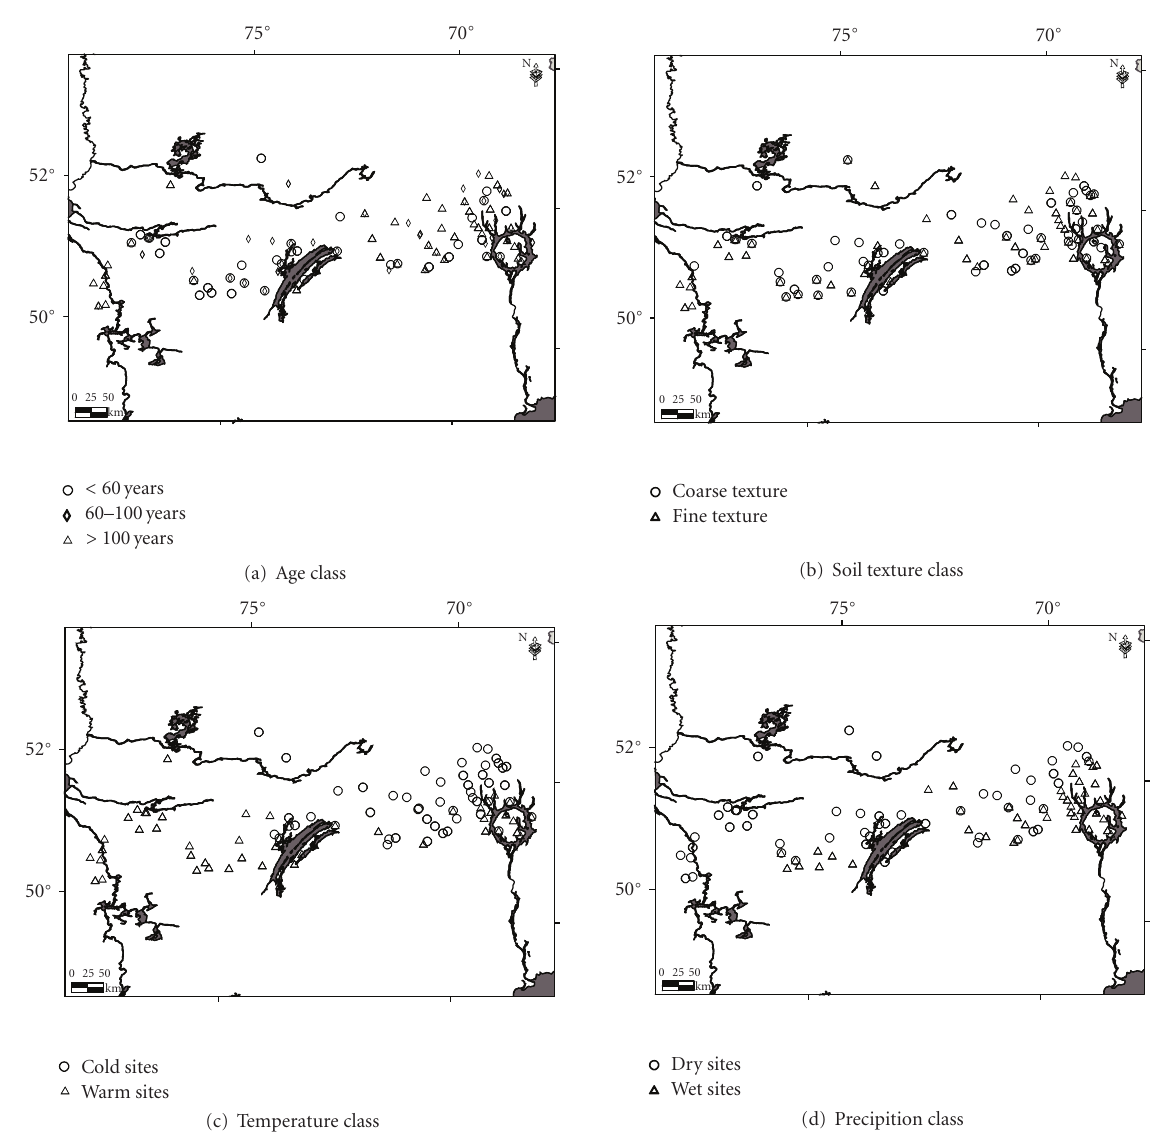
Figure 2: Distribution of stand age, soil texture, temperature, and precipitation classes throughout the study area.